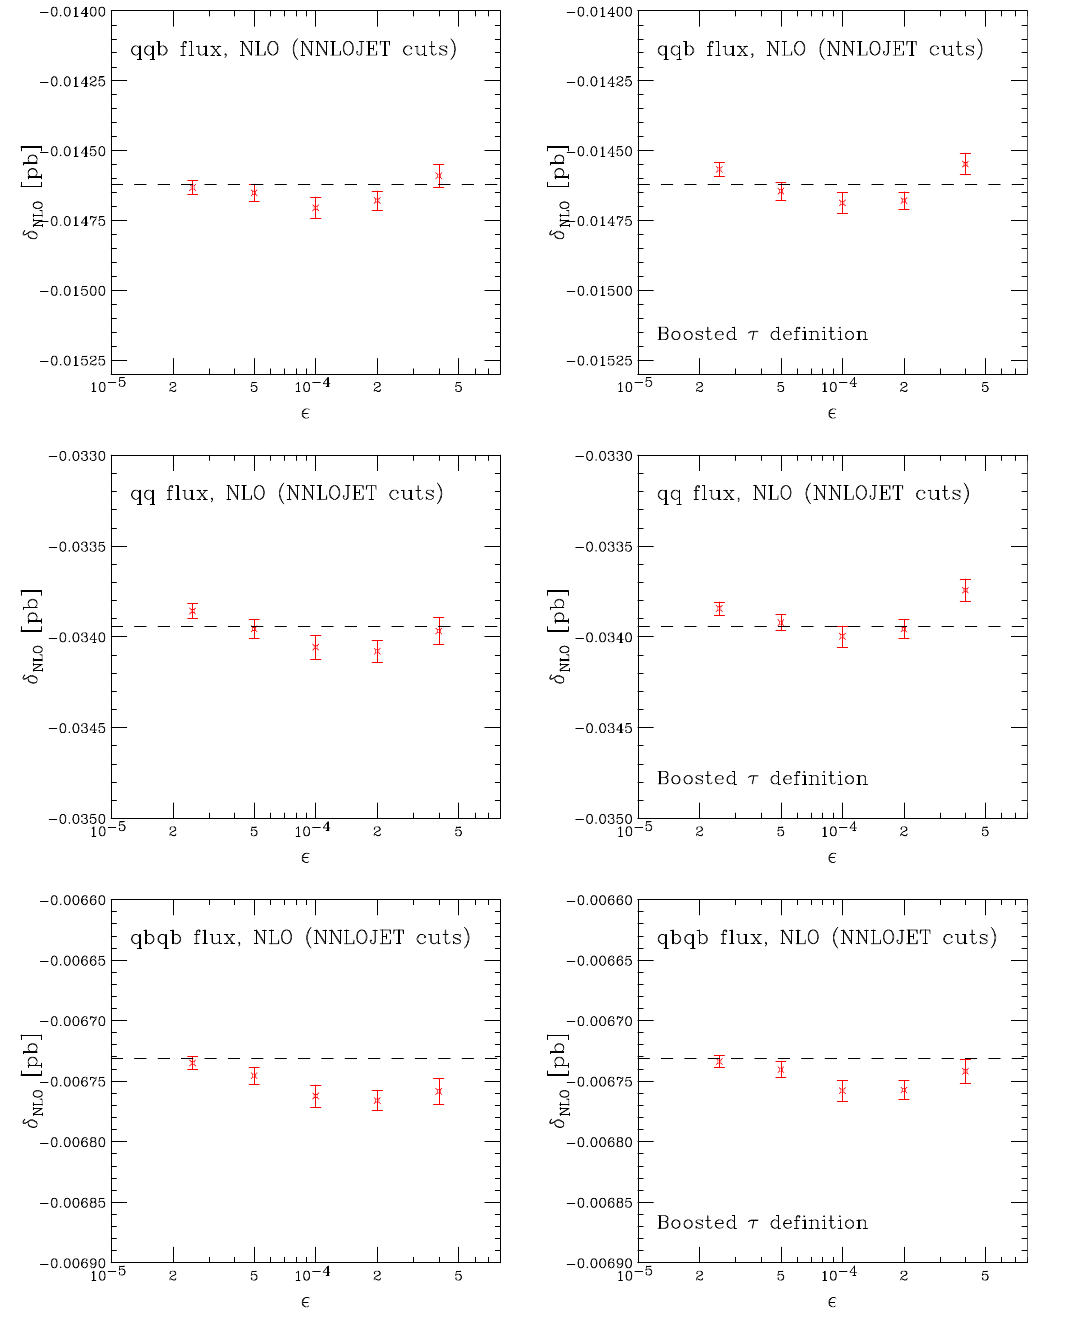
Figure 3 . (cid:28) -dependence of NLO coe(cid:14)cients for the q (cid:22) q , qq and (cid:22) q (cid:22) q partonic channels, in the NNLO- JET setup. The plots on the left show the result when T 1 is computed in the hadronic c.o.m. and the ones on the right indicate the corresponding result when evaluating this quantity in the boosted frame. The exact results, computed in MCFM using dipole subtraction, are shown as the black dashed lines.